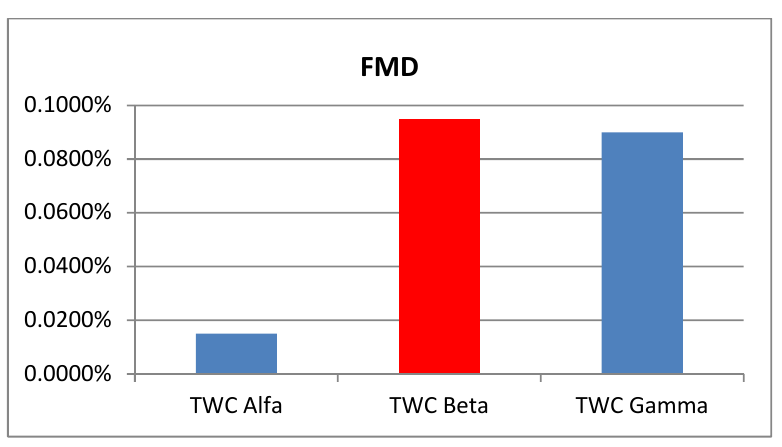
Figure 1. Areas of p > 0.95 according the Topological Weighted Centroid (TWC) α , β and γ , in Food and Mouth